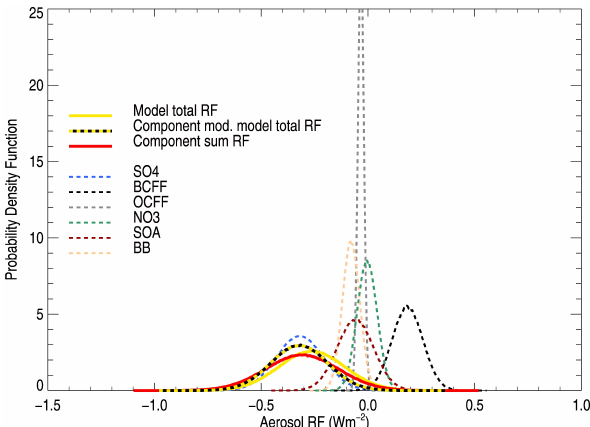
Fig. 16. Normalized PDFs of each aerosol component RF (dashed lines) based on the model spread shown above. The red line shows the mean of the modeled total aerosol RF, while the black line shows the spread when correcting for missing components as explained in the